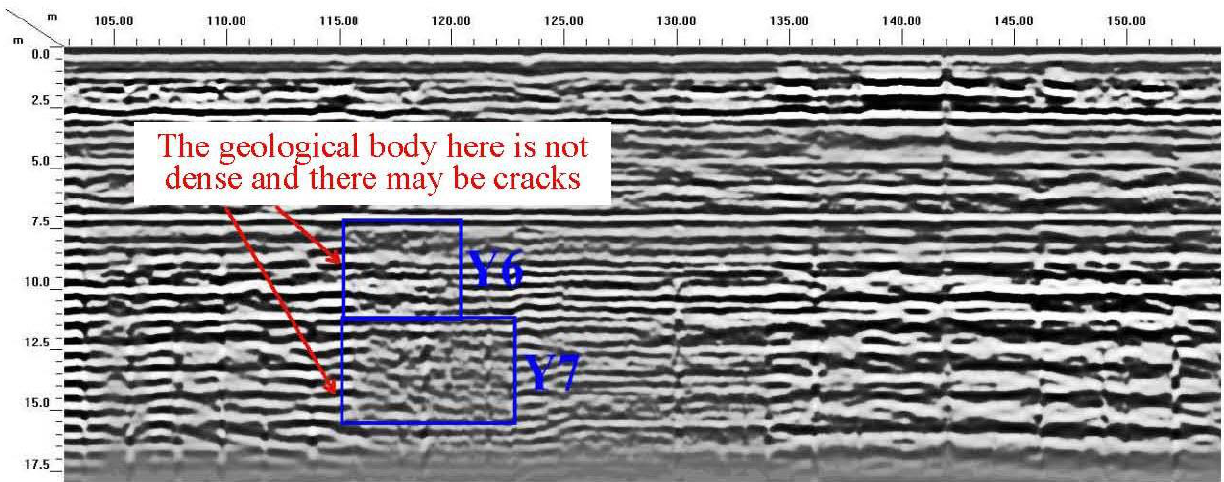
Figure 9. Non-destructive testing result of dam foundation.